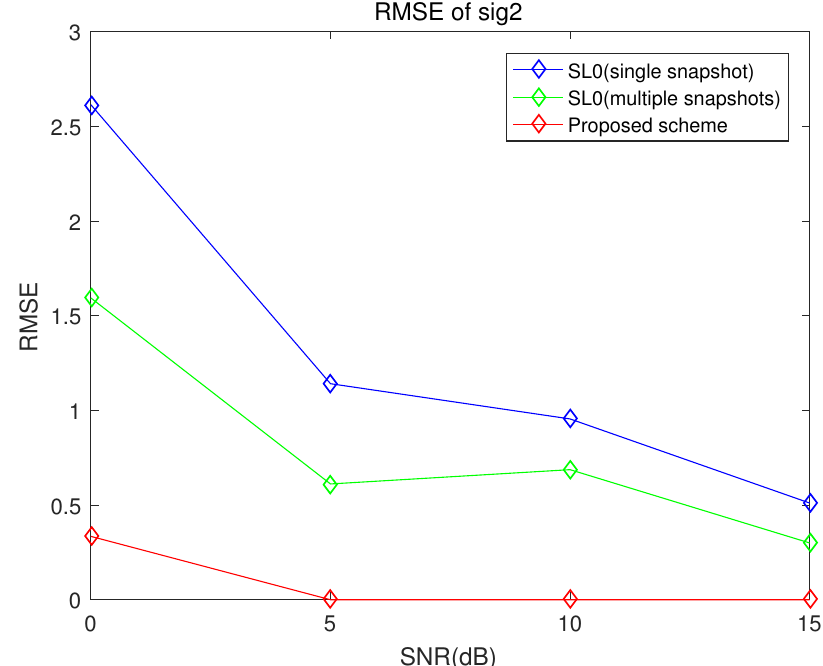
Figure 6. RMSE of the proposed scheme, the conventional smoothed l 0 norm method and multiple snapshots smoothed l 0 norm method when the number of sensors is 10, the number of samples is 100 and the incident angles are 5 ◦ and 20 ◦